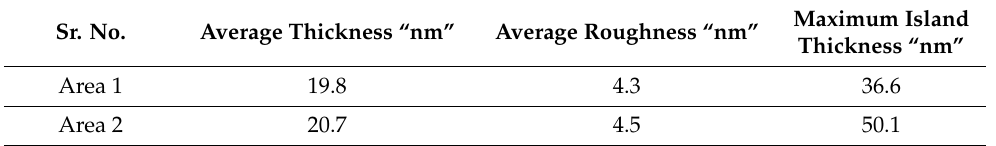
Figure 10. ( a , b ) AFM images of densely Cu-coated film showing the uniform film thickness, ( c , d ) AFM images of selected area of the Cu deposited island showing the maximum film thickness. Table 4. Statistical quantities of AFM analysis for Cu film for 5 min sample.